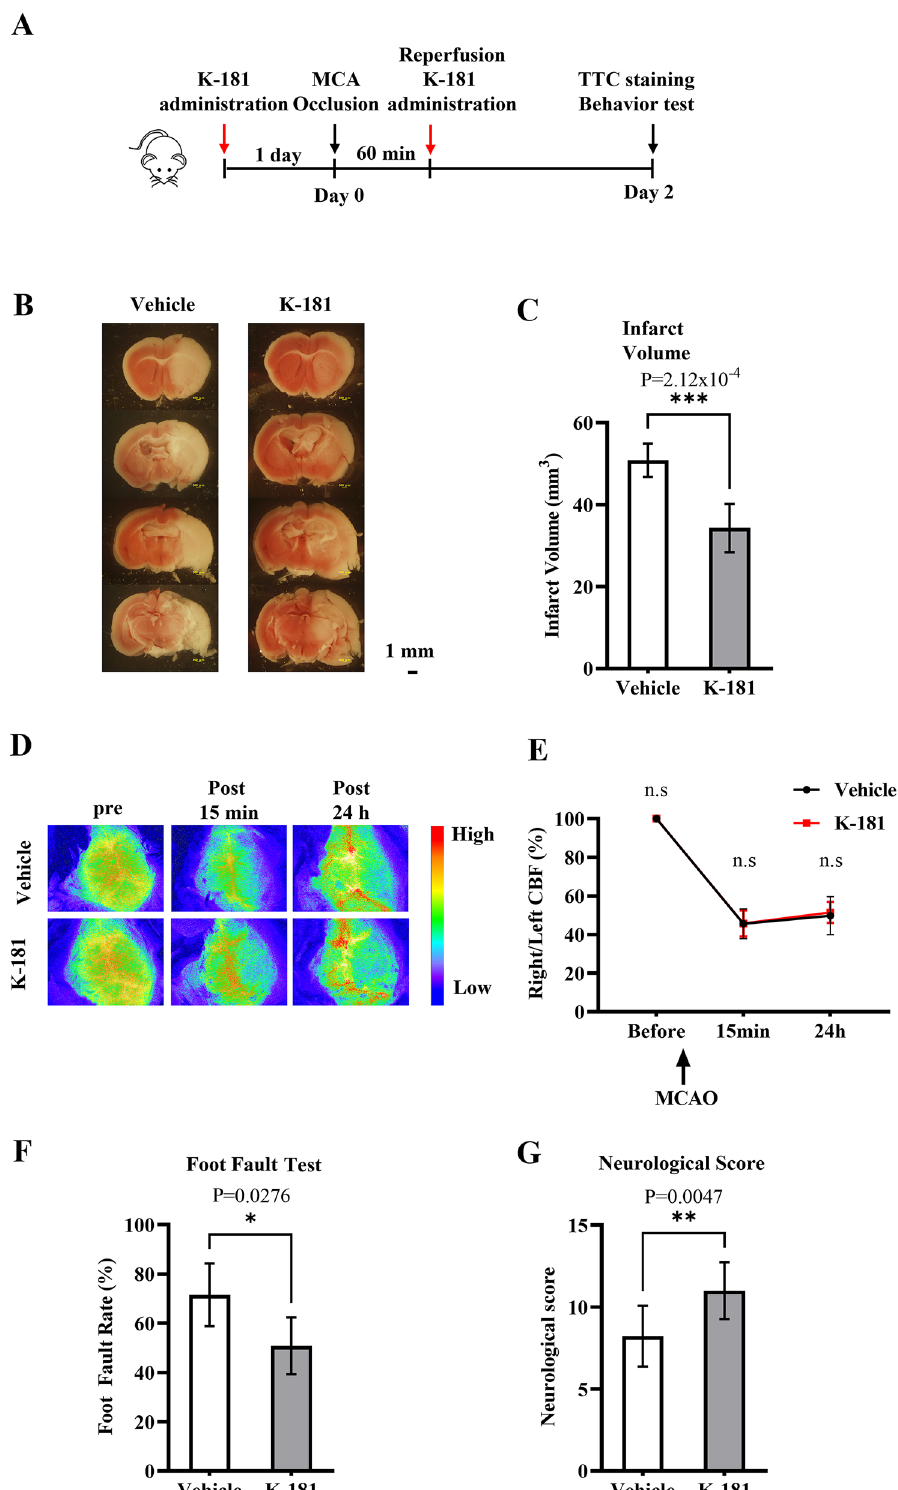
Figure 3. K-181 attenuates acute ischemic stroke damage in mice. ( A ) Mice were orally administrated with K-181 (50 mg/kg) twice, 1 day before and immediately after tMCAO. ( B , C ) Representative TTC staining images ( B ) and quantification ( C ) of mice infarct size 2 days after tMCAO. N = 6. Scale Bar = 1 mm. ( D , E ) Representative images ( D ) and quantification ( E ) of mice cerebral blood flow visualized by Omegazone. N = 6. ( F ) Foot Faut test of mice 48 h after tMCAO. N = 5. ( G ) Neurological score of mice 48 h after tMCAO. N =